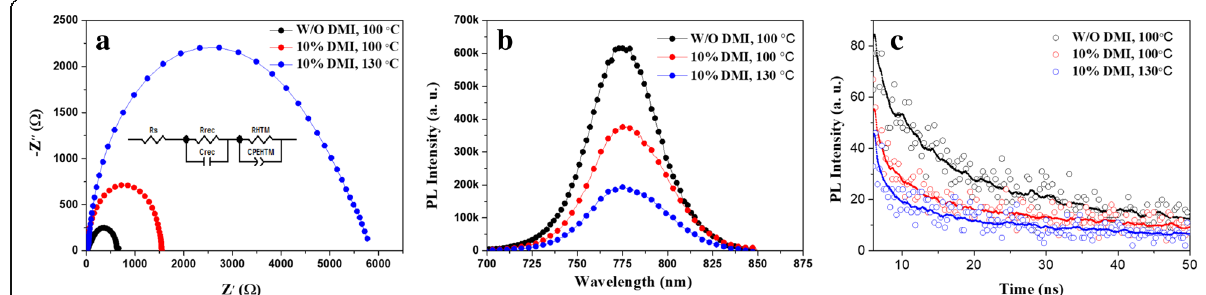
Fig. 5 a Nyquist plots of the perovskite solar cells in the dark at a bias of 0.9 V. b Steady PL spectra of the perovskite films. c Time-resolved PL spectra basing on the bi-exponential decay function fabricated from three different